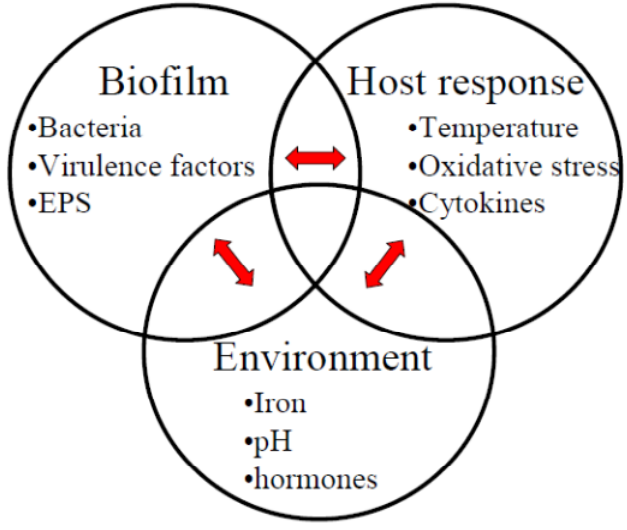
Figure 1. Interactions between periodontal pathogens and host in the subgingival